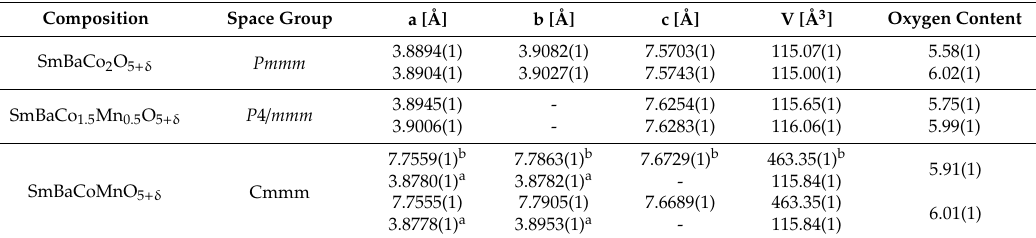
Table 1. Crystal structure parameters at room temperature calculated for SmBaCo 2 − x Mn x O 5 + δ (x = 0; 0.5 and 1) with equilibrium oxygen content as well as for fully-oxidized materials. Oxygen content was determined with the iodometric titration